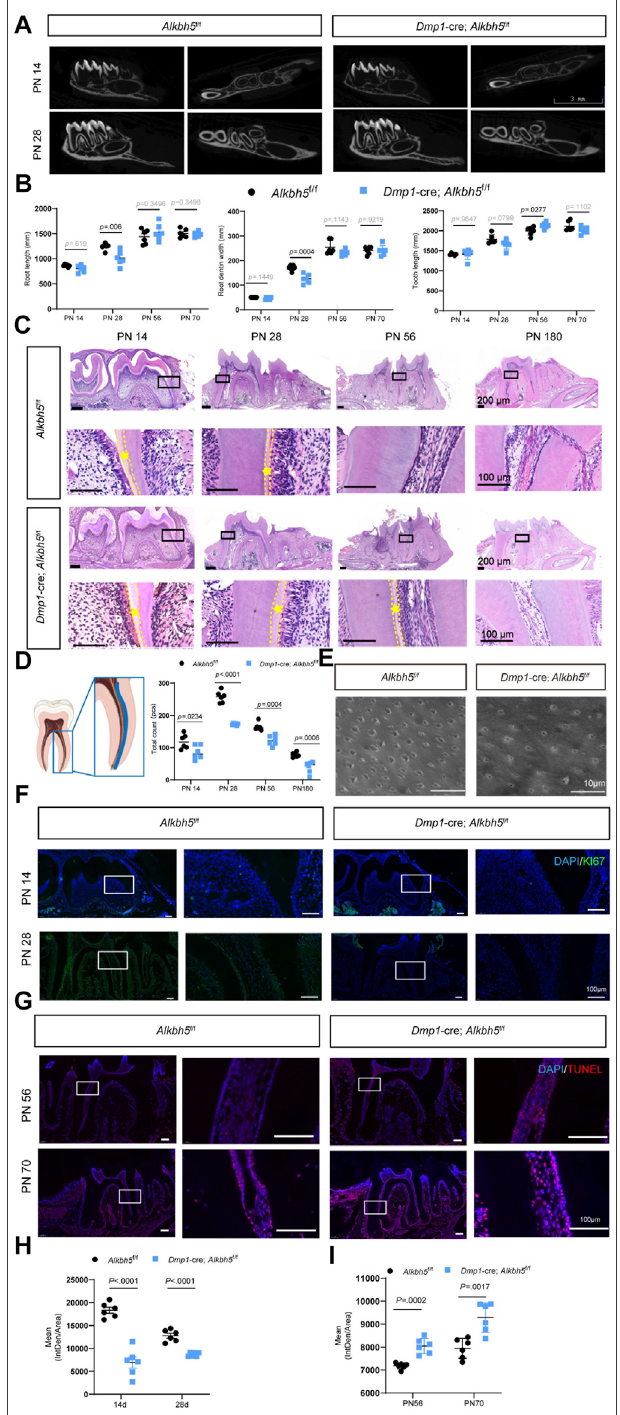
FIGURE 3 | Impaired primary dentin formation in Dmp1 -Cre; Alkbh5 fl / fl mice. (A) Structural μ CT imaging of the mandibular fi rst molars derived from Dmp1 -Cre; Alkbh5 fl / fl and Alkbh5 fl / fl mice at PN 14 and PN 28. Scale bar: 3 mm. (B) Quantitative μ CT analyses of root dentin width, root length, and tooth length at PN 14, PN 28, PN 56, and PN 70 from Dmp1 -Cre; Alkbh5 fl / fl and Alkbh5 fl / fl mice. (C) Representative H&E staining of the fi rst